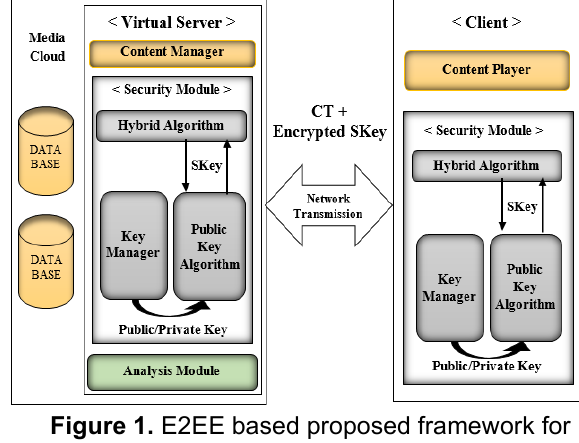
Figure 1. E2EE based proposed framework for multimedia cloud computing